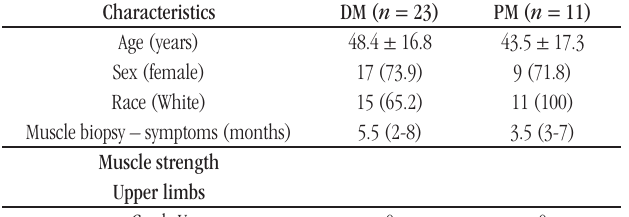
taBLE 2 − Comparative histological features between the different levels of histological sections of muscle biopsies from DM and PM patients Features Levels of histological sections